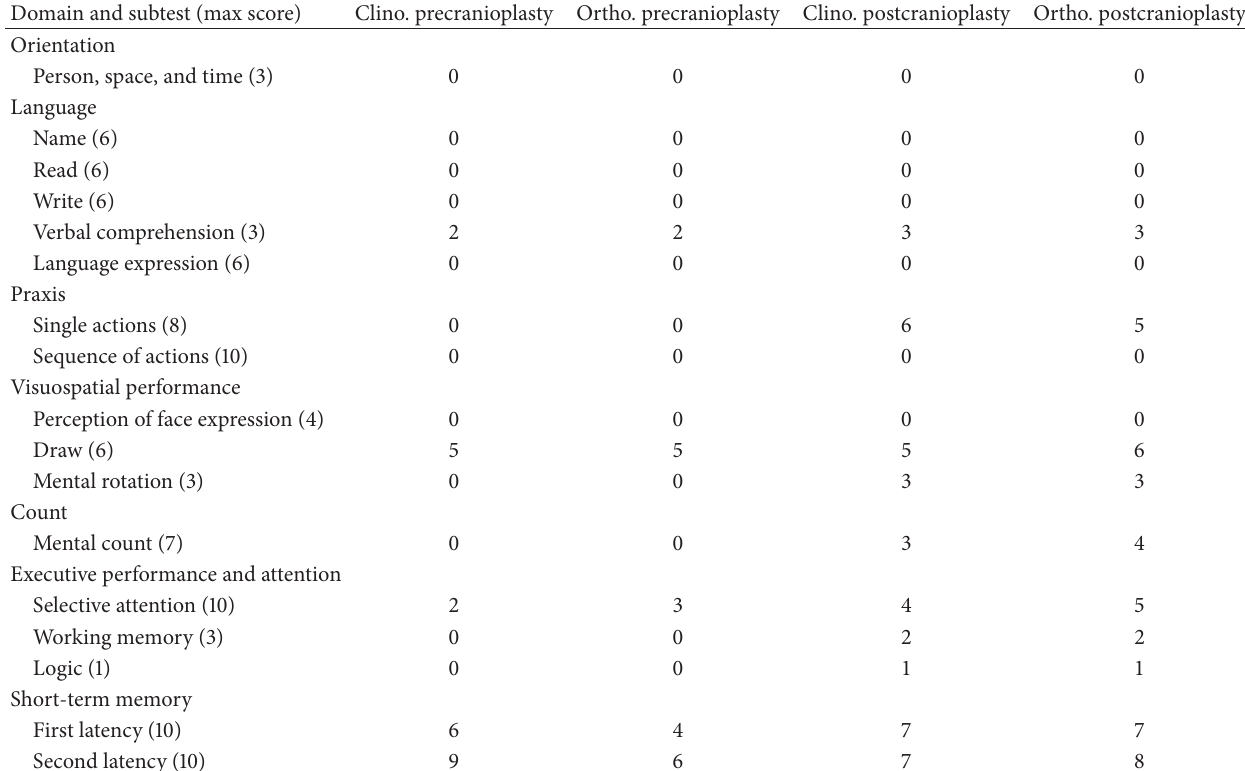
Table 1: Results of neuropsychological